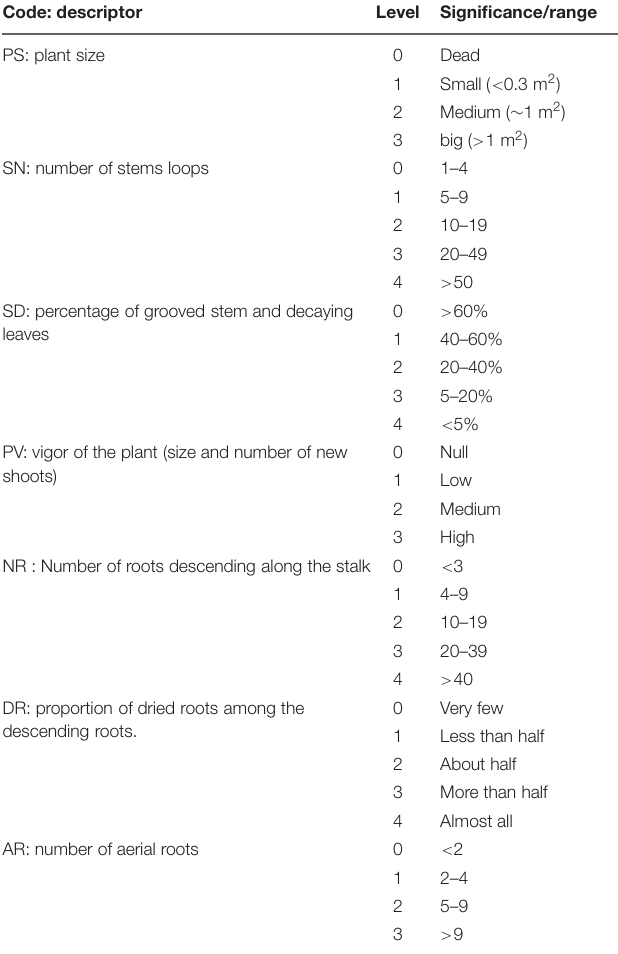
TABLE 2 | Growth (PS, SN, PV) and disease (SD, NR DR, AR) variables used for rating Forv resistance in the